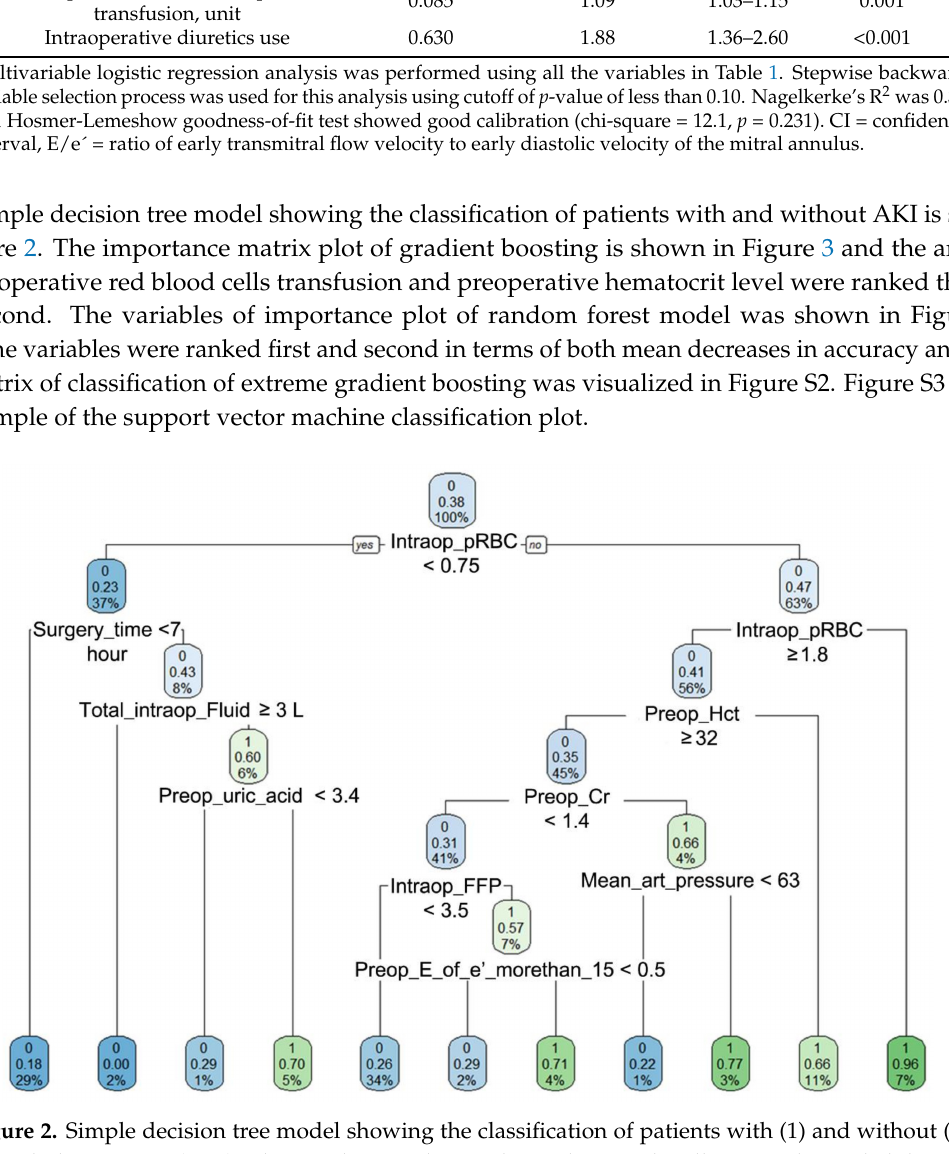
Figure 2. Simple decision tree model showing the classification of patients with (1) and without (0) acute kidney injury (AKI). The numbers with two decimals in each cell means the probability of developing AKI in each classification tree. The blue or green color becomes dense when it is more likely to develop acute kidney injury or not. The % number in the boxes denotes the percentage of patients with each discriminating variable from CART (Classification And Regression Tree) analysis. Intraop = intraoperative, preop = preoperative, pRBC = packed red blood cells, Hct = hematocrit, Cr = creatinine, FFP = fresh frozen plasma, E_or_e_prime = preoperative ratio of early transmitral flow velocity to early diastolic velocity of the mitral